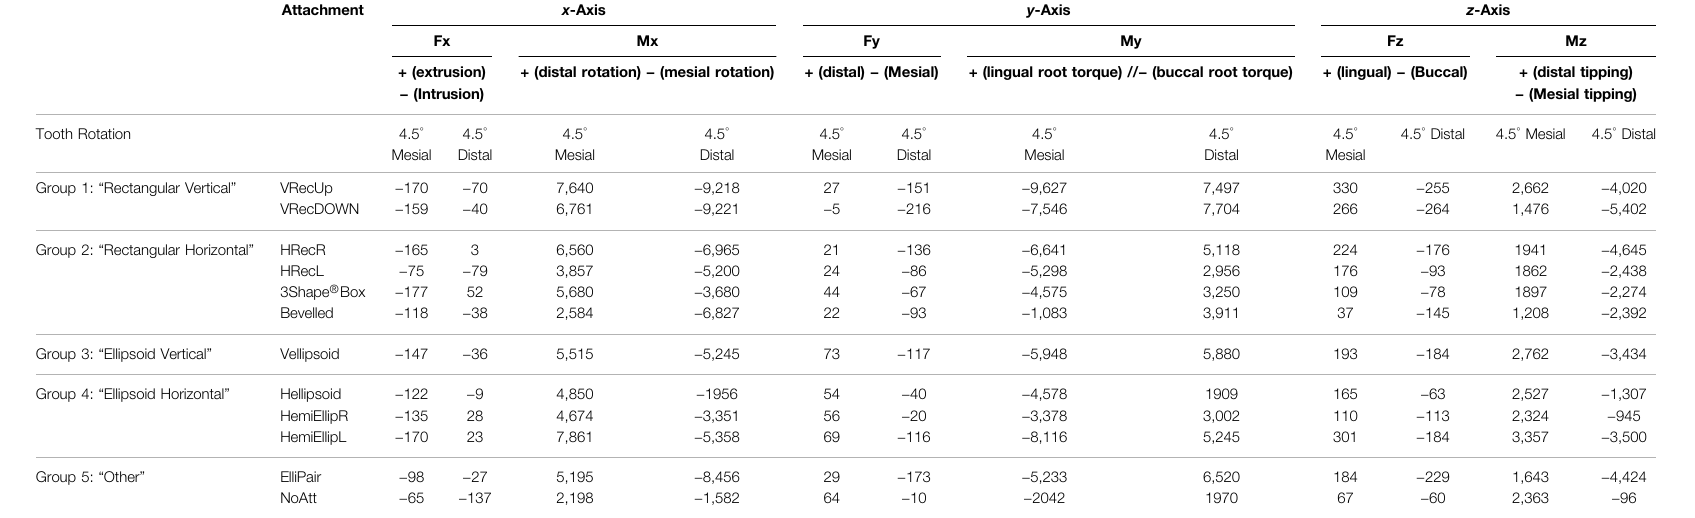
TABLE 1 | Forces (F, in cN) and moments (M, in cNmm) at the fi nal positions of 4.5 mesial and 4.5 distal rotations. When the test tooth is 4.5 mesial rotated, forces and moments are created to disto-rotate the tooth (Mx positive). Attachment